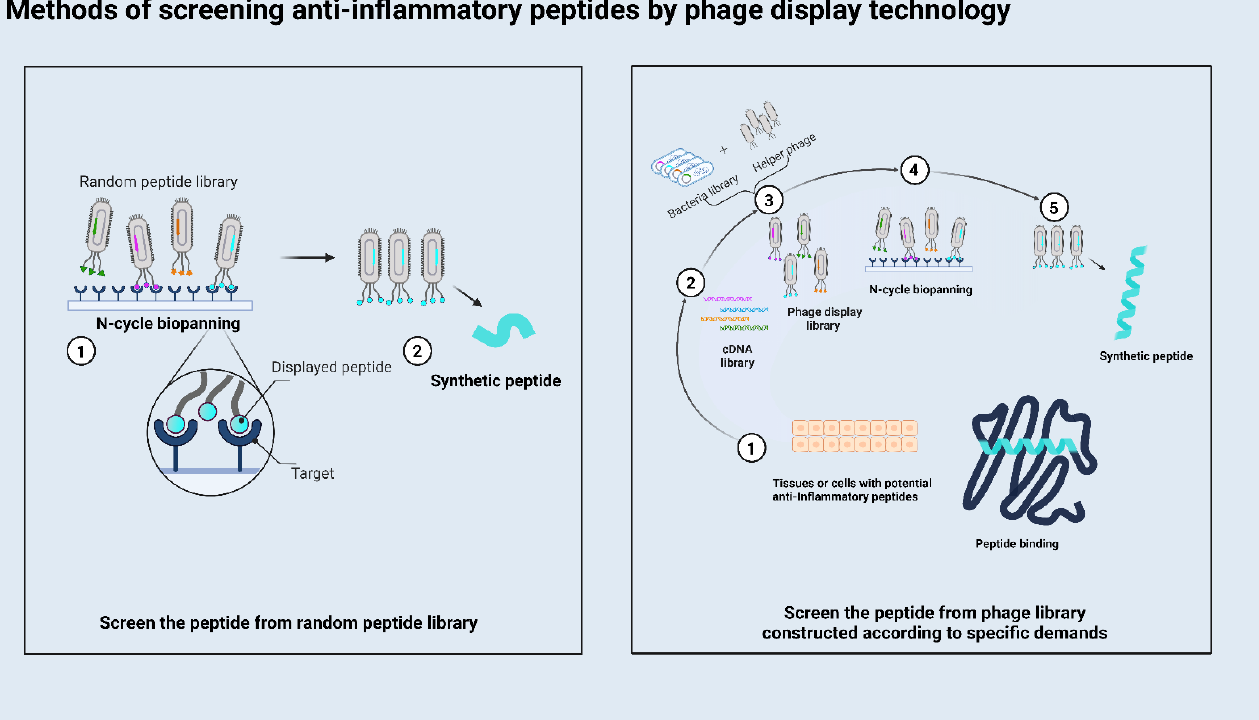
Figure 1. This figure depicts the two most commonly used methods for screening anti-inflammatory therapeutic peptides. The left is the flowchart of screening the peptide from the random peptide library; the right is the flowchart of screening the peptide from the construct library.